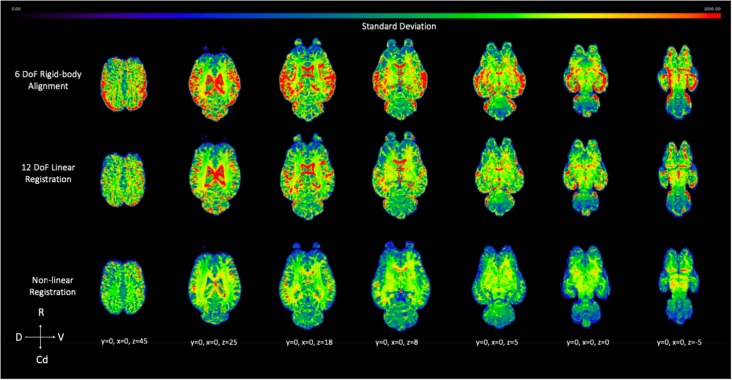
Demonstrates the effect of 12 DoF linear registration and non-linear registration on the inter-subject spatial variability. The voxel intensity within the spatial maps represents the degree of standard deviation for the five testing subjects after 6 DoF rigid body alignment (top row), 12 DoF linear registration (middle row) and non-linear registration (bottom row) to the template (R, rostral; Cd, caudal; D, dorsal; V, ventral).